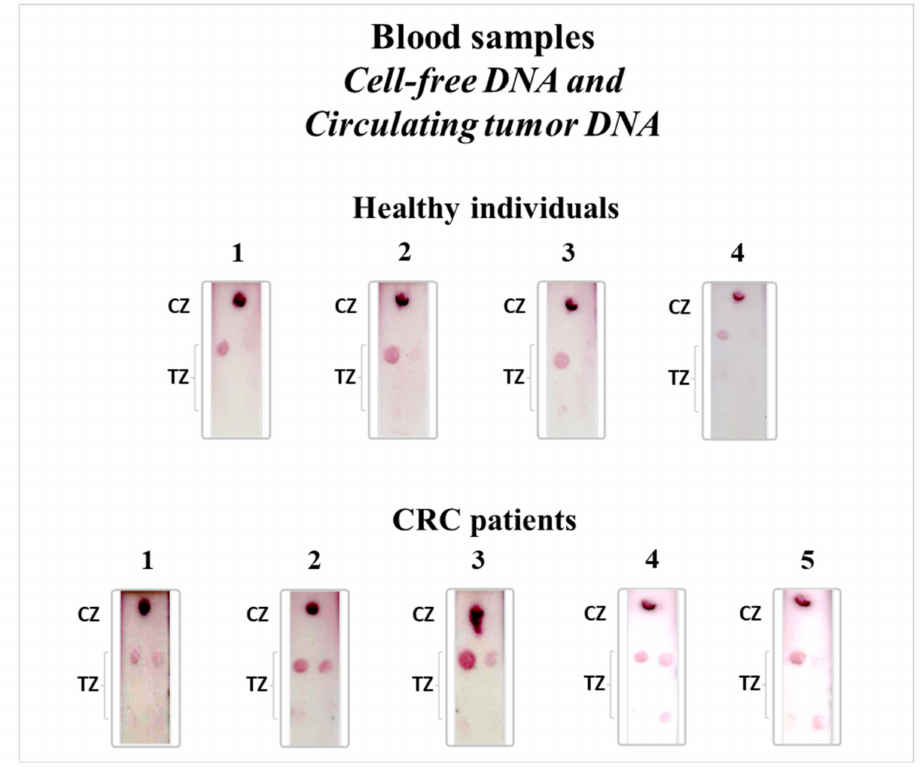
Figure 5. Application of the multiplex strip test for the detection of cell-free DNA and circulating tumor DNA in blood samples of four healthy individuals and five CRC patients. CRC: colorectal cancer, TZ: test zone, CZ: control